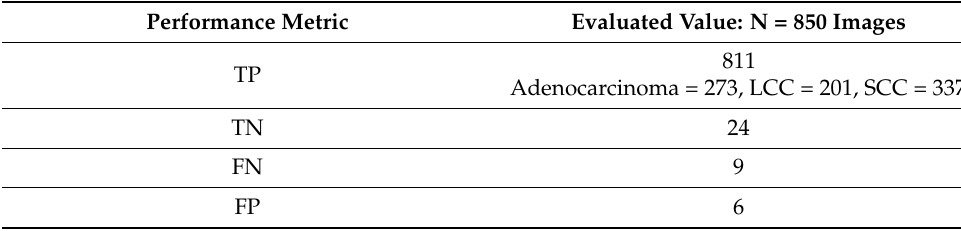
Table 5. The achieved outcomes of